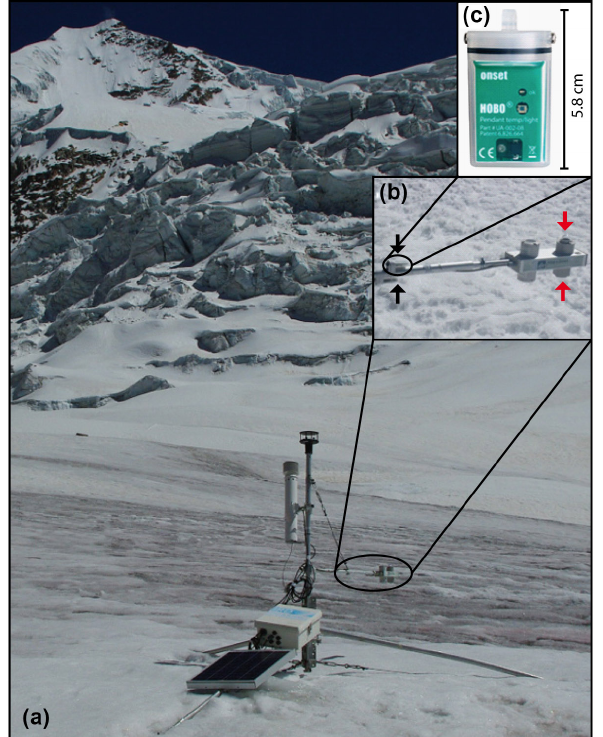
Figure 1. (a) Meteorological station on the Zongo Glacier; (b) CNR1 radiometer (Kipp & Zonen) installed at the SAMA meteo- rological station (the CM3 pyranometers are the two sensors on the right, red arrows) and the LCA comprised of two HOBO ® Pen- dant Temperature/Light Data Loggers (black arrows); (c) zoomed- in view of a HOBO ® Pendant Temperature/Light Data Logger (see Table 1 for detailed characteristics).